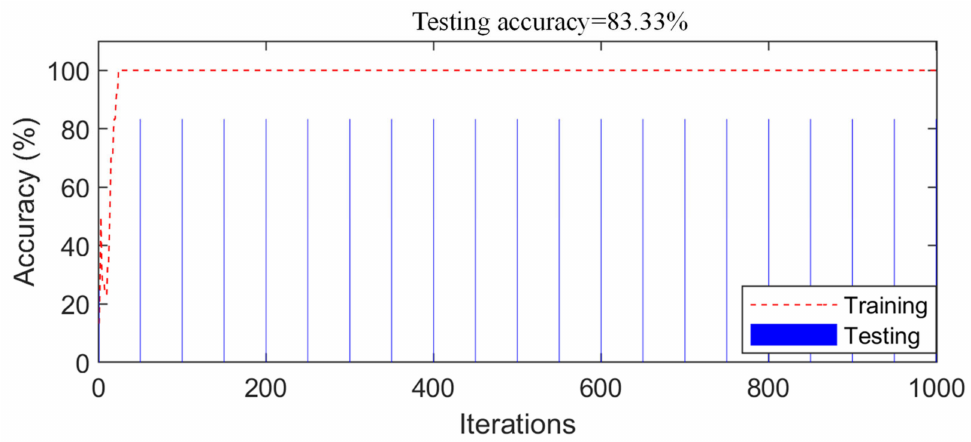
Figure 14. Detection results of the control experiment (experimental bridge model).